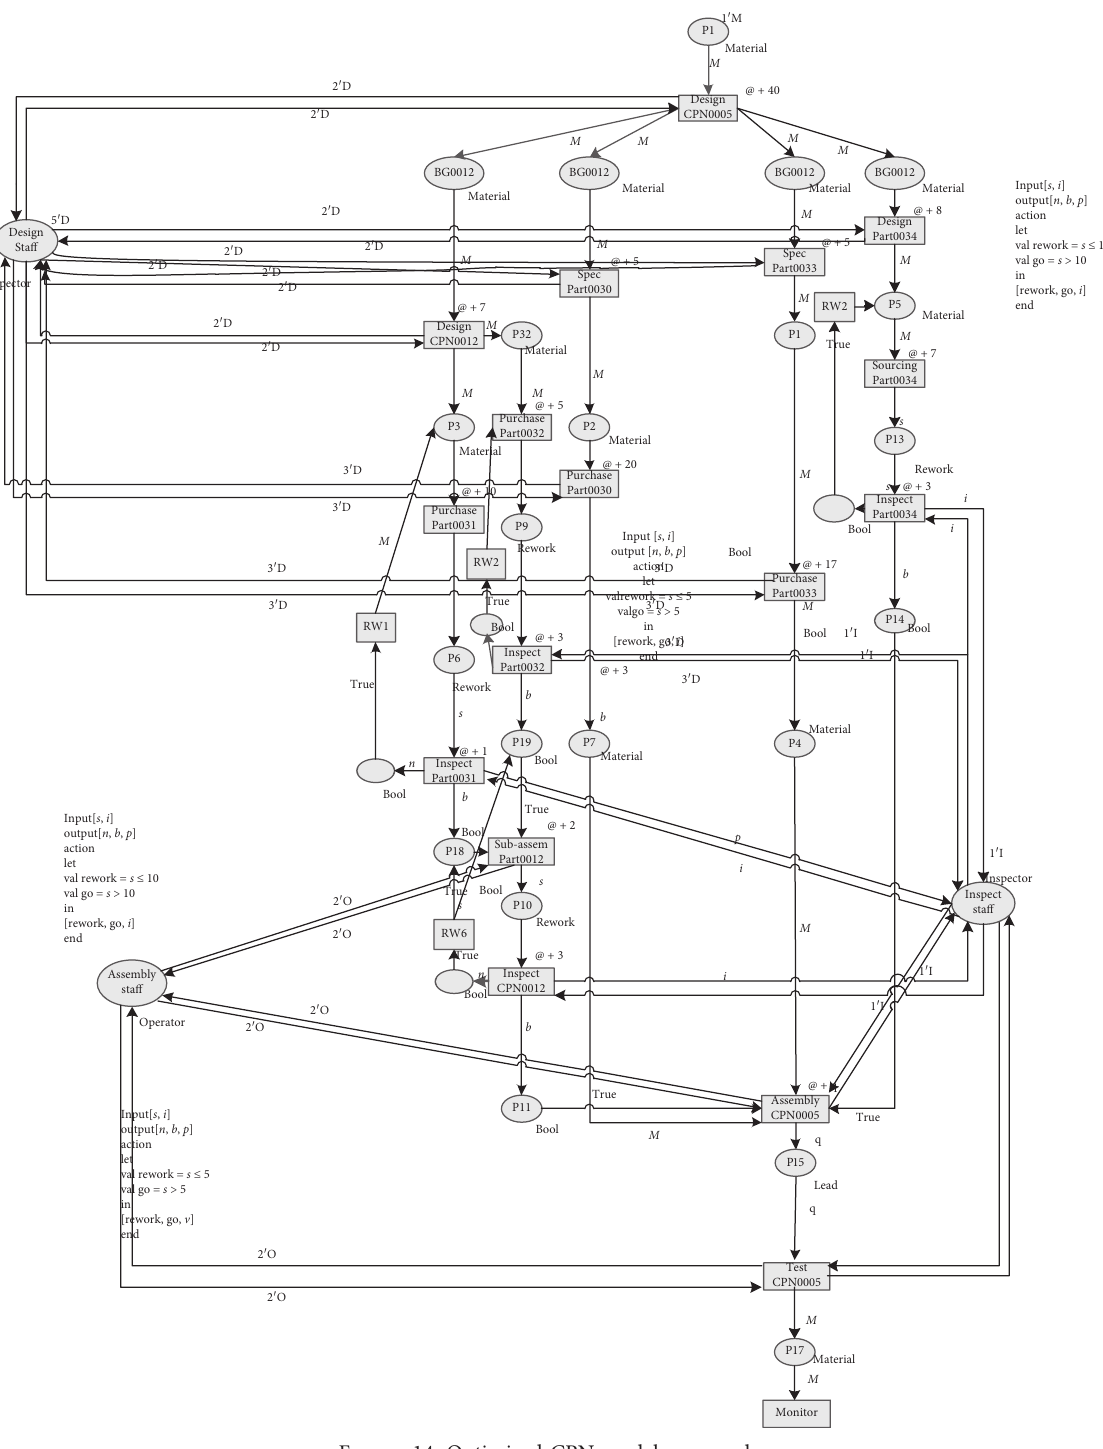
Figure 14: Optimized CPN model proposed.